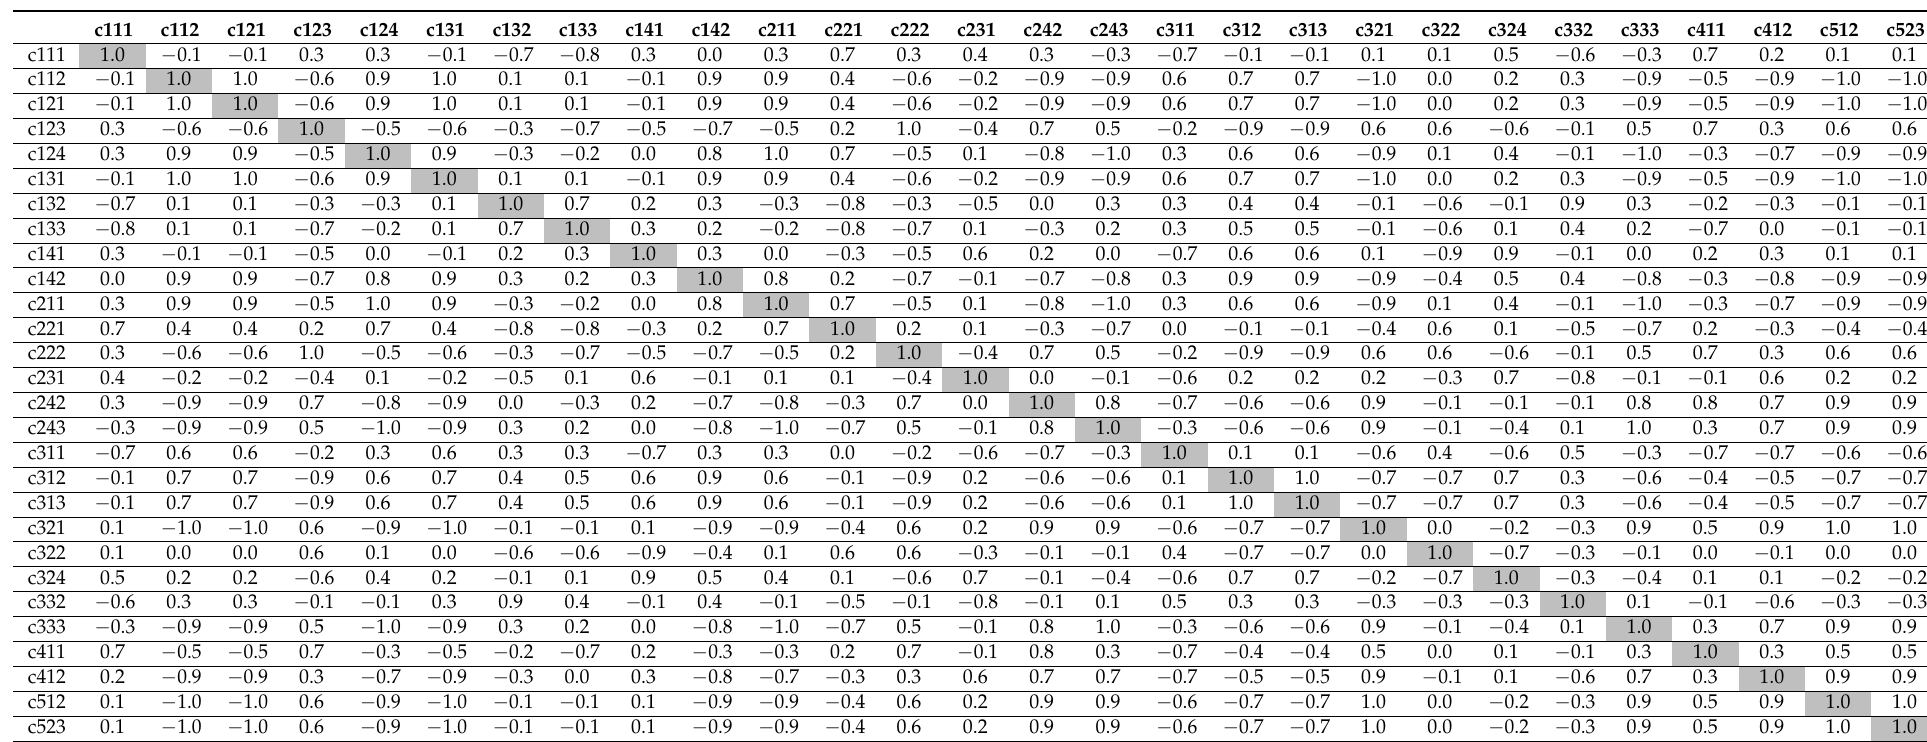
Table A1. Spearman’s rank correlation coefficient values in the Azores archipelago for land-uses at level 3 according to the CLC nomenclature between 1990 and